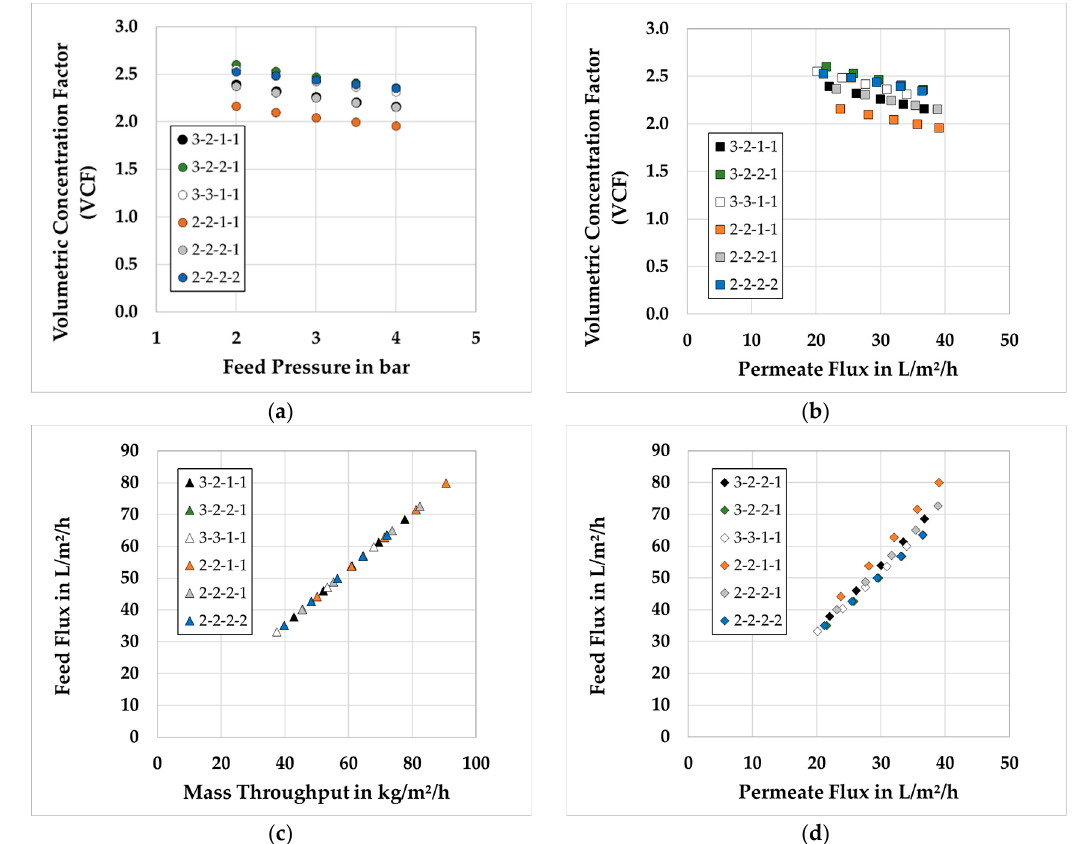
Figure 8. Simulated values for different setups ( a ) Volumetric concentration factor vs. feed pressure ( b ) Volumetric concentration factor vs. permeate flux ( c ) Feed flux vs. Mass throughput ( d ) feed flux vs. permeate flux.